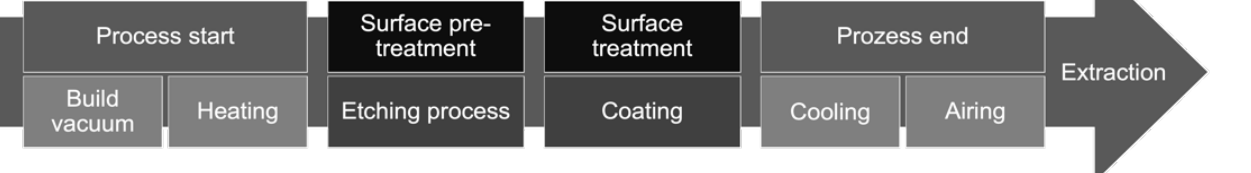
Figure 3. PVD coating process [27,28].